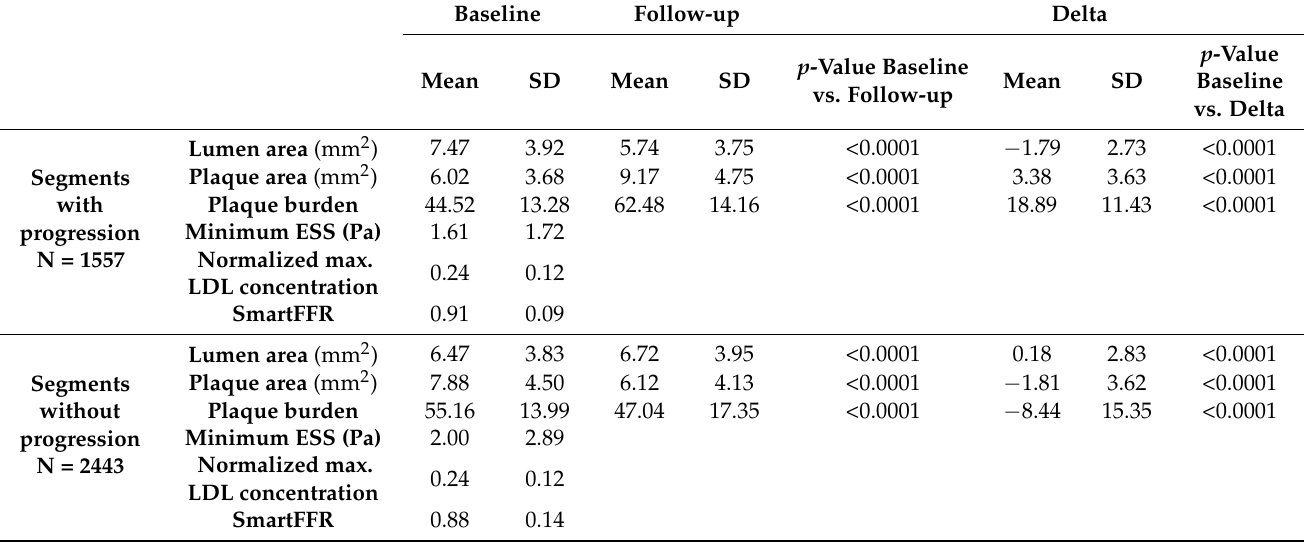
Table 3. Same variables as in Table 2 in segments without plaque progression (N = 1556) and with plaque progression (N =